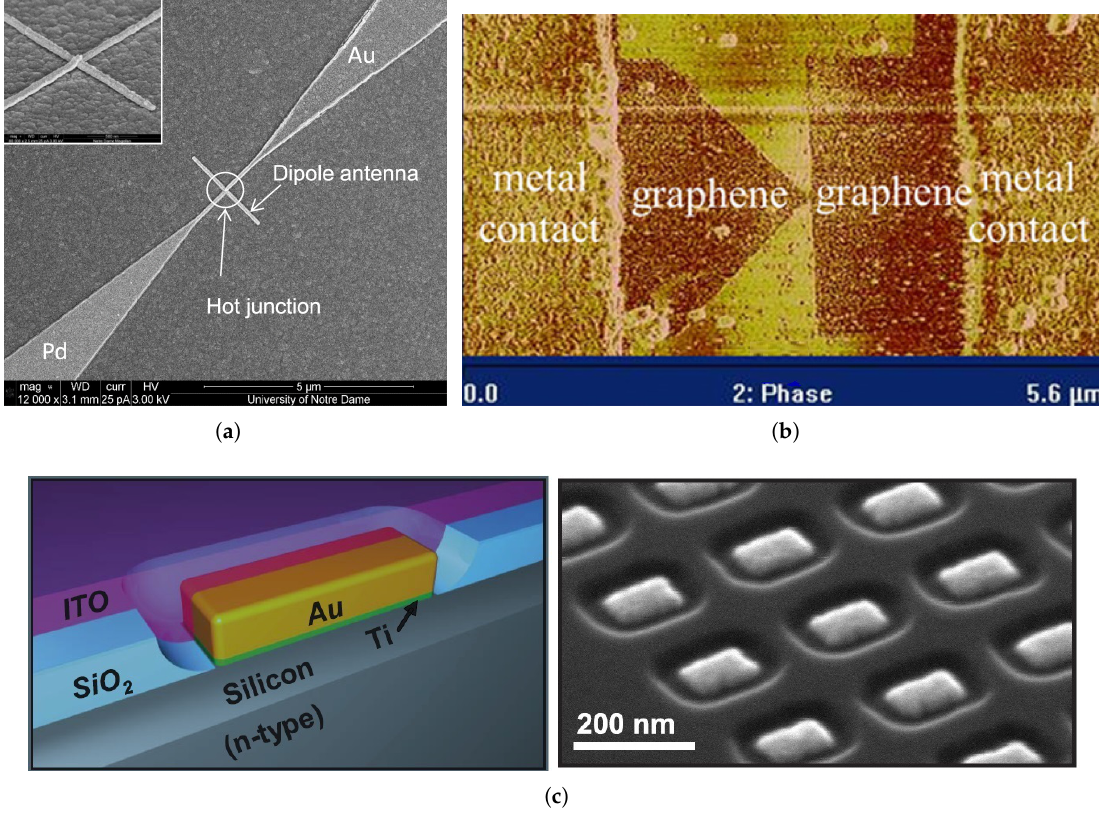
Figure 13. Examples of some different sensing techniques: ( a ) Thermocouple [23], ( b ) Geometric diode [68], ( c ) Schottky diode representation (left) and fabricated device before ITO coating (right)